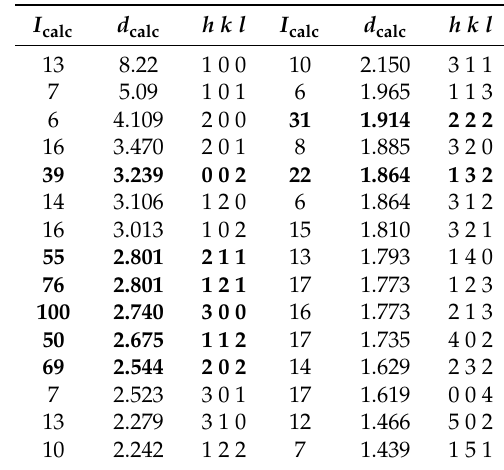
Table 7. Calculated X-ray powder diffraction data ( d in Å) for parafiniukite. Intensity and d hkl were calculated using the software PowderCell 2.3 [22] on the basis of the structural model given in Table 3. Only reflections with I calc > 5 are listed, if not observed. The eight strongest reflections are given in